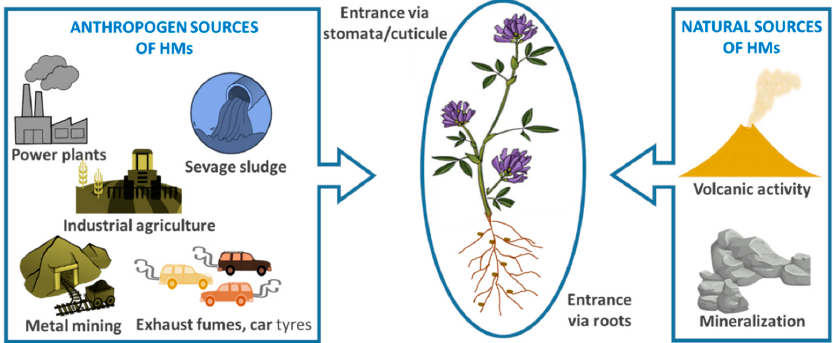
Figure 1. Anthropogenic and natural sources of heavy metals in the environment.